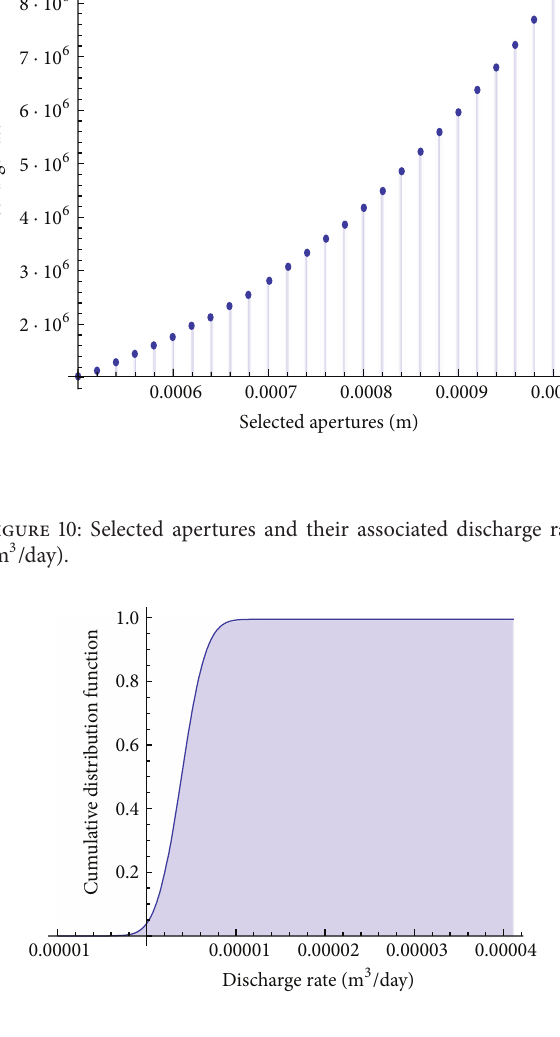
Figure 11: Cumulative distribution function for selected discharge rate (m 3 /day).